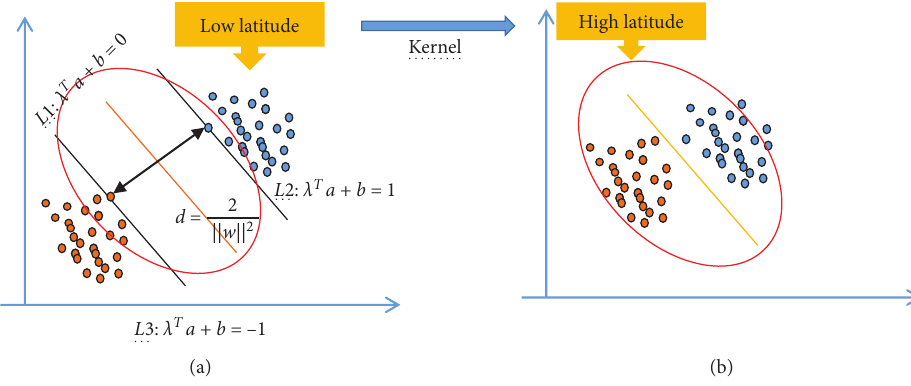
Figure 3: Linearly inseparable support vector machine model. Table 1: Simulation test platform parameter setting. Platform parameters